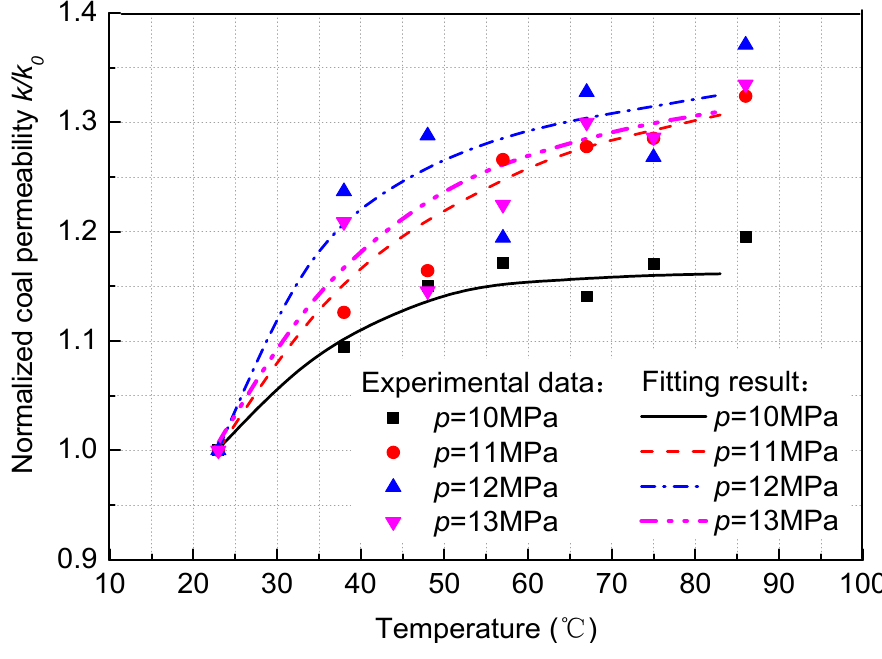
Figure 3. Validation of coal permeability model with experimental data. Table 1. Fitting parameters for coal permeability